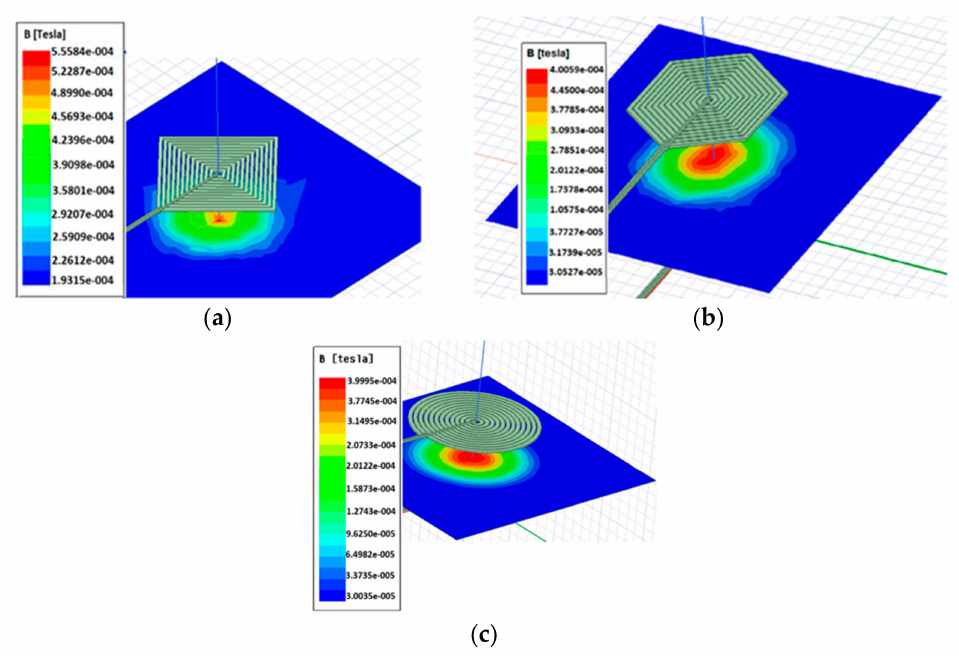
Figure 5. The modelling and simulation results of the square ( a ), hexagonal ( b ) and circular ( c ) coil topologies.